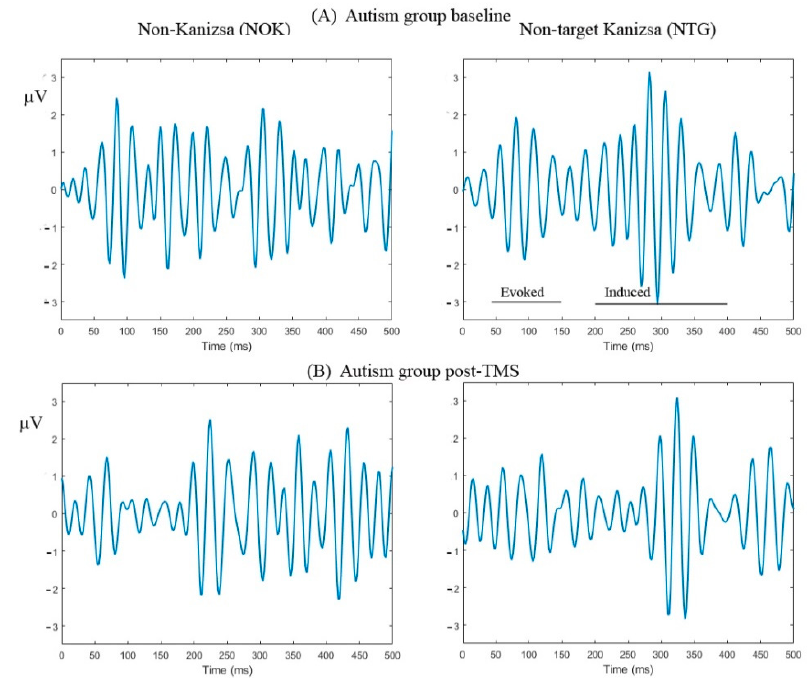
Figure 2. Evoked and induced gamma oscillations in response to task-irrelevant non-target Kanizsa and non-Kanizsa stimuli in children with ASD at the baseline ( A , upper raw) and post-TMS treatment ( B , lower raw) at the parietal sites (P7, P8). Magnitude of both evoked and induced gamma oscillations decreased post-transcranial magnetic stimulation (TMS).